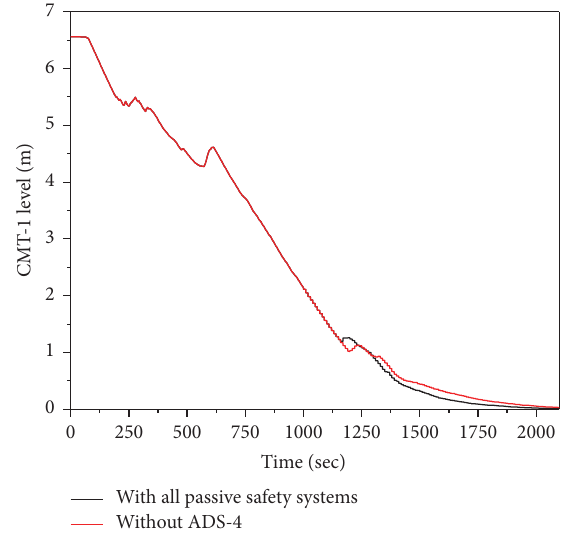
Figure 18: Comparison of CMT water level in case-1 and case-4.